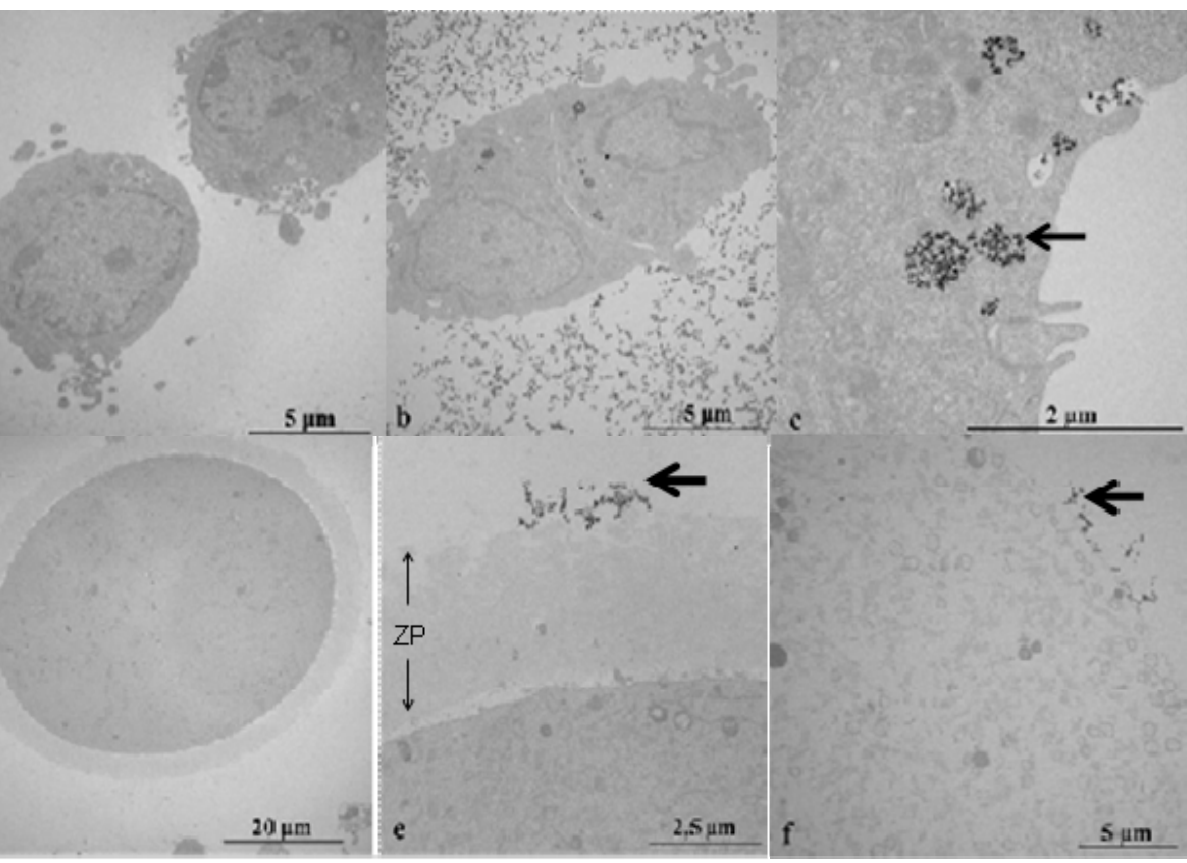
O NPs e 2 O e 2